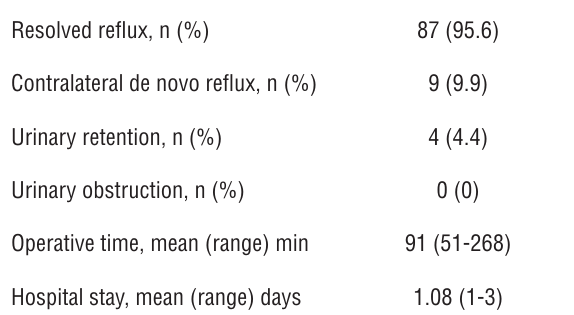
Table 2 - Outcomes.